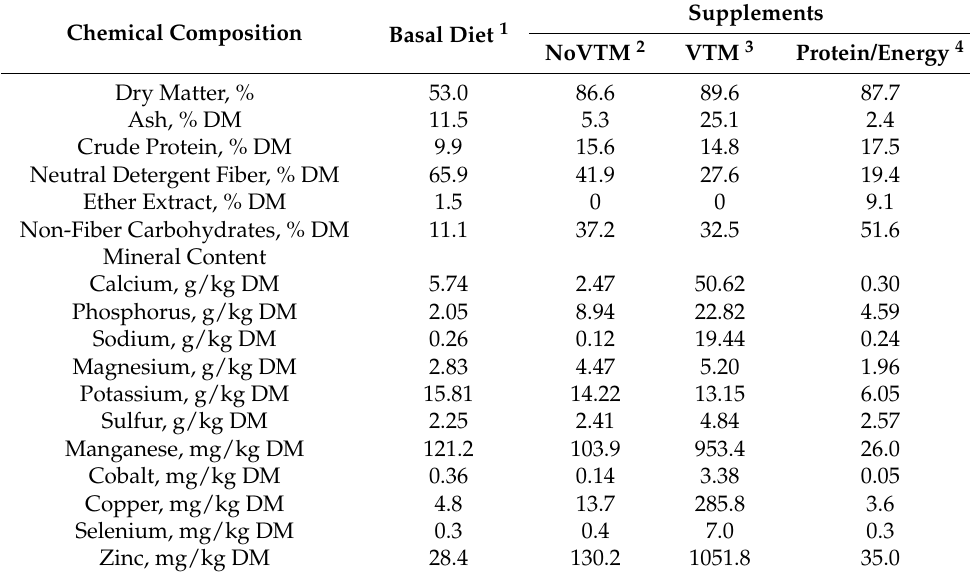
Table 2. Nutrient composition of basal diet and supplements provided to replacement beef heifers during the first trimester of